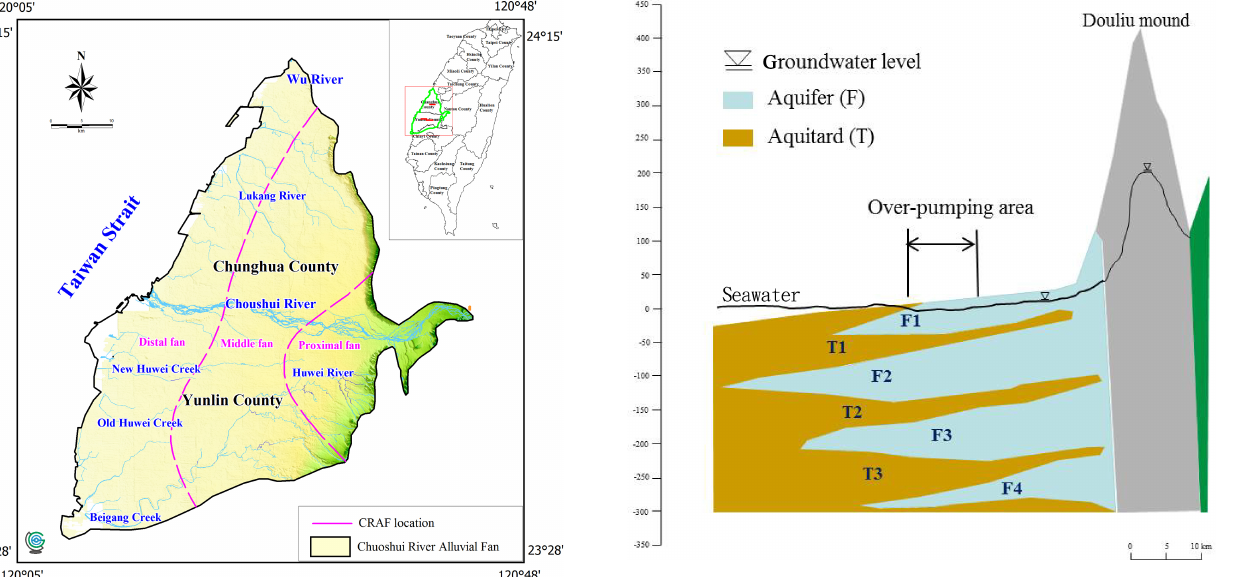
Figure 1. Geographical location of Choushui River Alluvial Fan (CRAF).